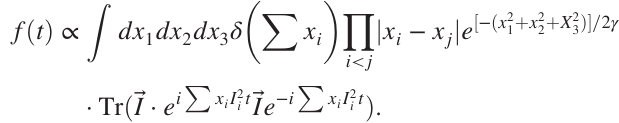
FIG. 5. The calculated normalized Overhauser correlator f for the various types of nuclear spins which comprise the QD. I is the mean value of the correlator taking into account mean the isotopic abundances weighted by their squared magnetic